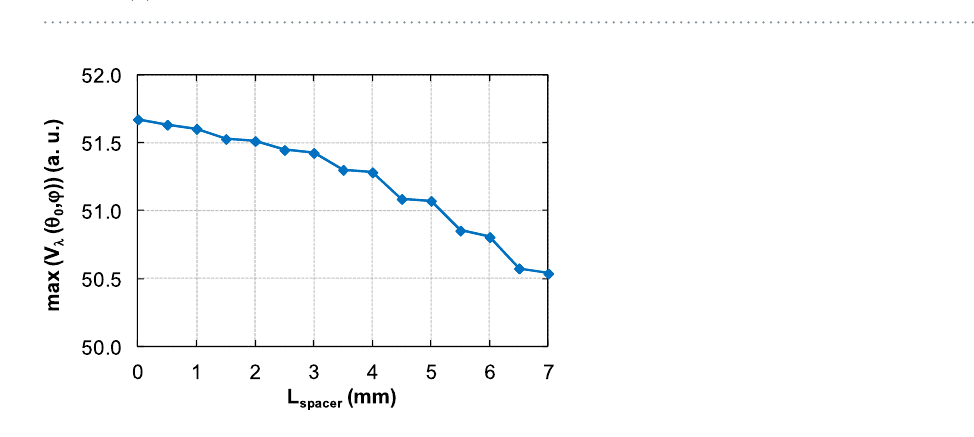
Figure 4. Selection of DHR standards according to characteristics of analyzed samples. ( a ) Specular vs. diffuse surfaces. ( b ) Low reflectance surfaces – reflectance differences.